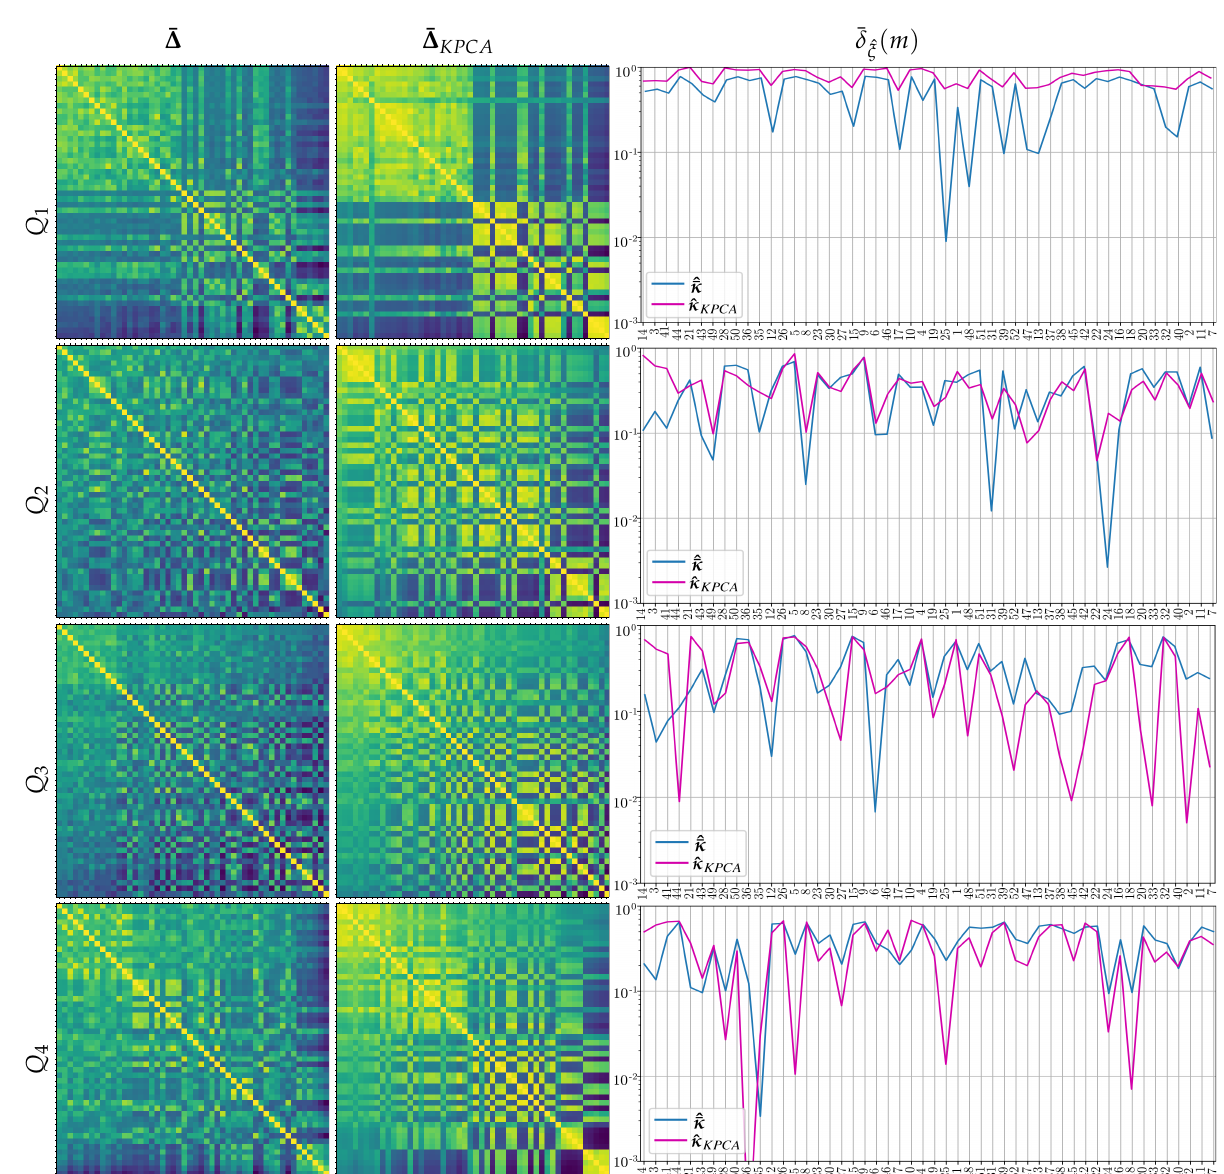
( m ) . The subjects are ξ